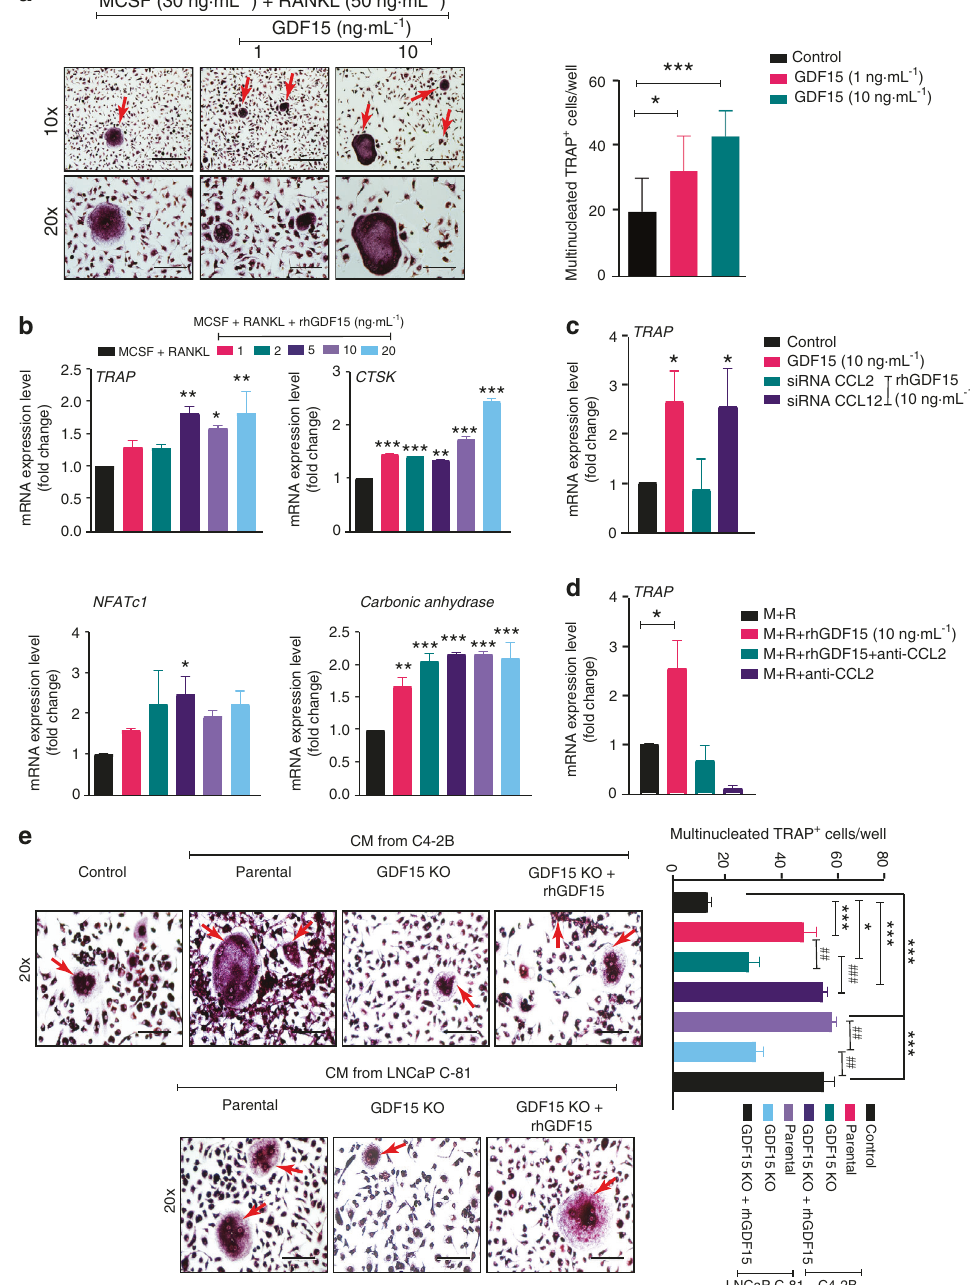
Fig. 5 PCa-secreted GDF15 induces osteoclastogenesis. a BMMs from C57BL/6J mice were induced to differentiate toward osteoclasts with M-CSF and RANKL in the presence or absence of different concentrations of exogenous rhGDF15 (1 and 10 ng·mL − 1 ). After 7 days of culture, the cells were stained for TRAP and photographed by light microscopy to observe the multinucleated TRAP-positive cells (fused cells with 3 + nuclei) known as osteoclasts (left panel) . Scale bars = 400 µm (upper) and 200 µm (lower). Quanti fi cation of multinucleated TRAP + cells in different experimental groups ( right panel ). b To determine the effect of GDF15 on osteoclastogenesis, RT – qPCR analyses showing the mRNA expression of osteoclast markers ( TRAP, cathepsin K, NFATc1, and carbonic anhydrase ) using the same treatment regimen as in (Fig. 5a) were performed. BMMs from C57BL/6J mice were cultured for 7 days in the presence of RANKL and M-CSF and/or rhGDF15 along with c siRNA of CCL2 and CCL12 d and an anti-CCL2 antibody (10 µg·mL -1 ), and the expression levels of TRAP transcripts were analyzed. e BMMs cultured in the presence of RANKL and M-CSF and/or rhGDF15 along with CM from C4-2B and LNCaP C-81 cells (parental and GDF15 KO cells). After fi xation, the cells were stained for TRAP and photographed by a light microscope (left panel) . Scale bar = 200 µm, and the results are quanti fi ed in the right panel . The data represent the mean ± SEM. P ≤ 0.05 was considered to indicate statistical signi fi Recent reports have indicated that GFRAL and RET act as a the tibiae from C4-2B-injected mice compared to the tibiae from receptor and coreceptor of GDF15, respectively 18 – 21 ; however, the C4-2B GDF15 KO-injected mice, suggesting that the increase in RANKL expression is due to GDF15-mediated osteoblast presence and role of these receptors in bone cells have not yet differentiation. (Fig. 6c) been reported. IHC analysis showed that GFRAL and RET were